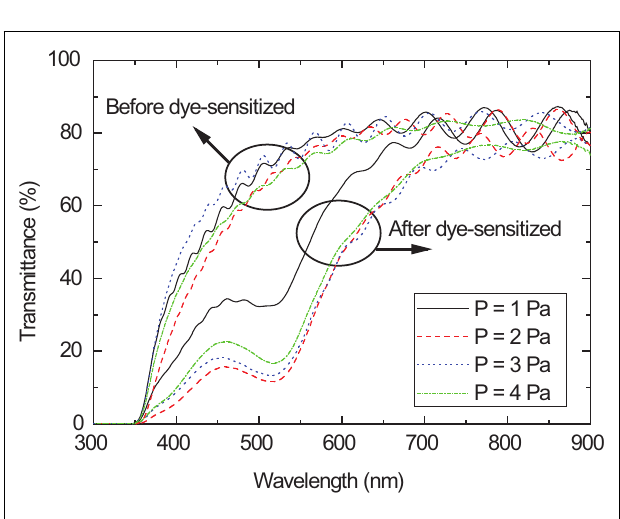
FIGURE 7 |Variations of the short-circuit current density (A), the open-circuit voltage (B), the fill factor (C), and the conversion efficiency (D) as a function of the sputtering pressure .